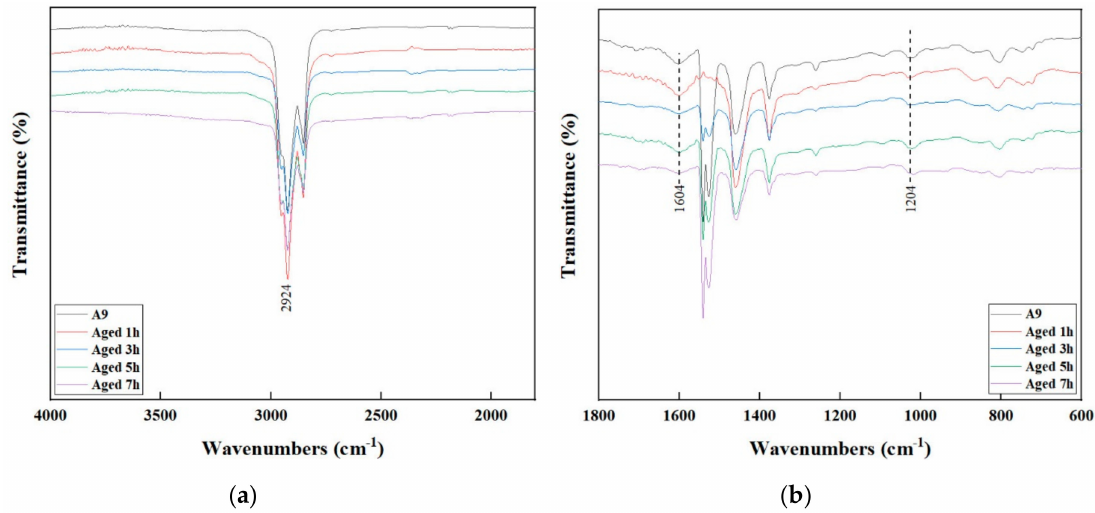
Figure 5. FTIR spectra of A9 at di ff erent aging times. ( a ) 4000 to 1500 cm − 1 ; ( b ) 1800 to 600 cm − 1 .